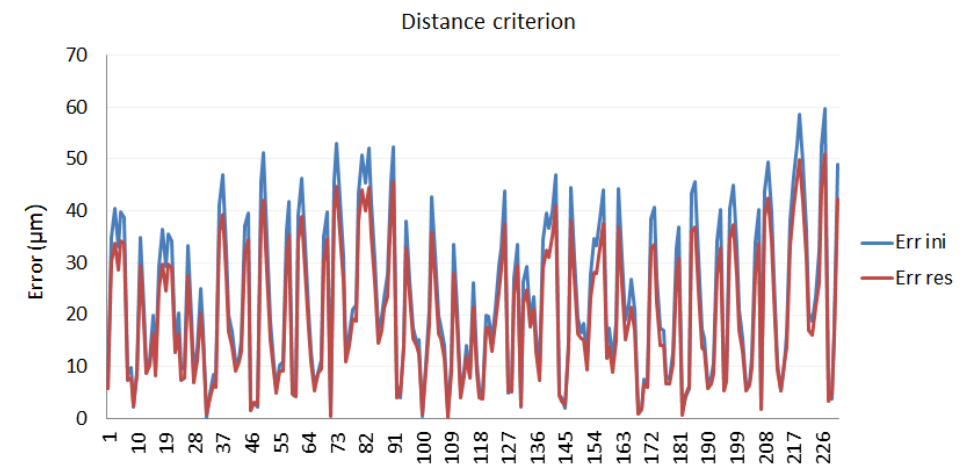
Figure 12. Calibration verification using the distance criterion.